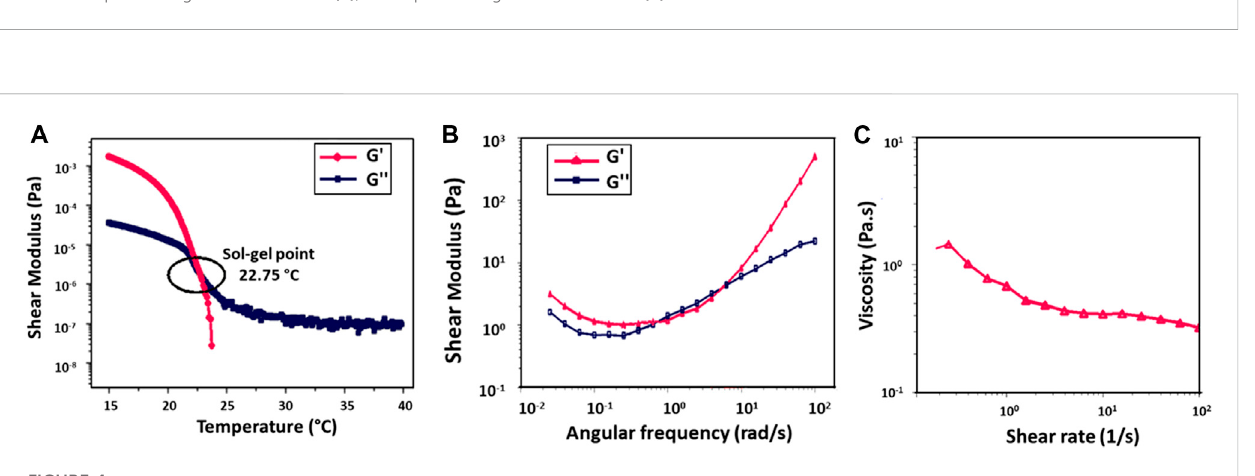
Frontiers in Bioengineering and